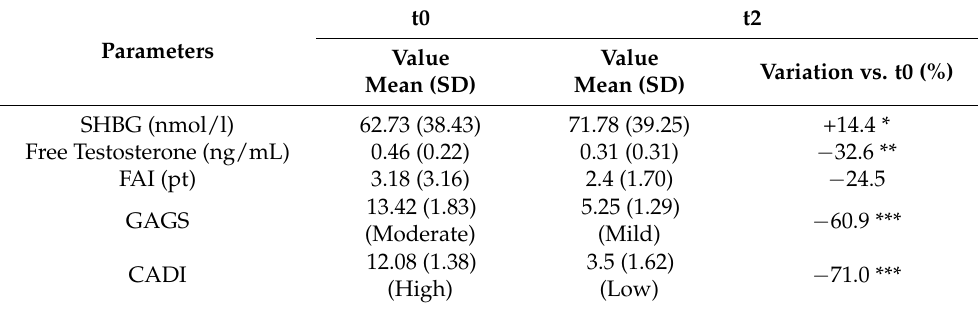
Table 3. Descriptive statistics for the hormonal pattern and acne status measured at baseline (t0) and after 60 days (t2) of BBR-PP supplementation.